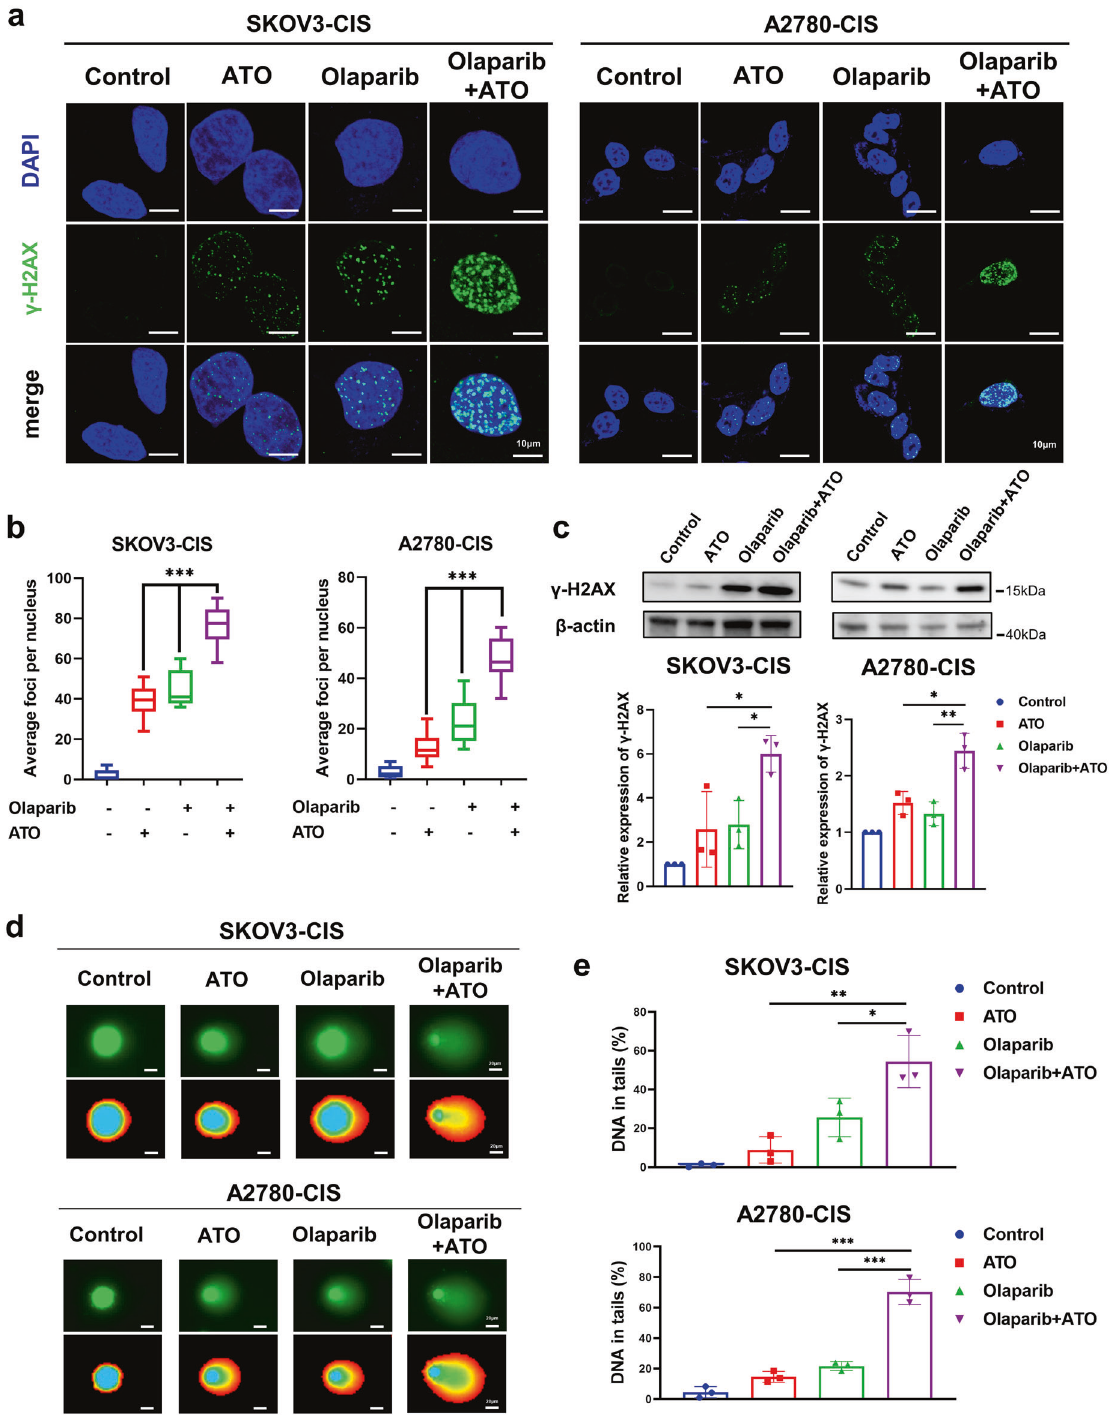
Fig. 3 Olaparib and ATO synergistically promote cell apoptosis by increasing DNA damage in platinum-resistant OC cells. SKOV3-CIS and A2780-CIS cells were treated with DMSO, olaparib (250 μ M for SKOV3-CIS, 50 μ M for A2780-CIS), ATO (3 μ M) or their combination for 48 h. a Representative immuno fl uorescence images of γ -H2AX foci in cells after indicated treatment. Magni fi cation is ×100, scale bar = 10 μ m. b Quanti fi cation of the number of γ -H2AX-positive foci in each nucleus based on immuno fl uorescence in SKOV3-CIS and A2780-CIS cells subjected to indicated treatments. Data was presented as mean ± SD from 50 cells. c Protein expression of γ -H2AX in cells after indicated treatment, detected using western blot. The protein expression levels were normalized with β -actin. The normalized value of the control group was set to 1. d Representative images DNA damage in SKOV3-CIS and A2780-CIS cells after different treatment, measured by comet assay, scale bar = 20 μ m. e Quanti fi ed results by the tail moment in the comet assay obtained from 50 cells in each group. Error bars are shown as mean ± SD from three independent